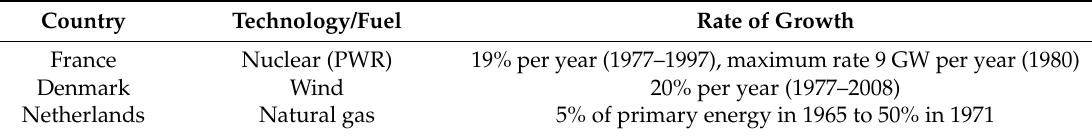
Table 2. Rate of growth of technologies and energy resources in rapid energy transition